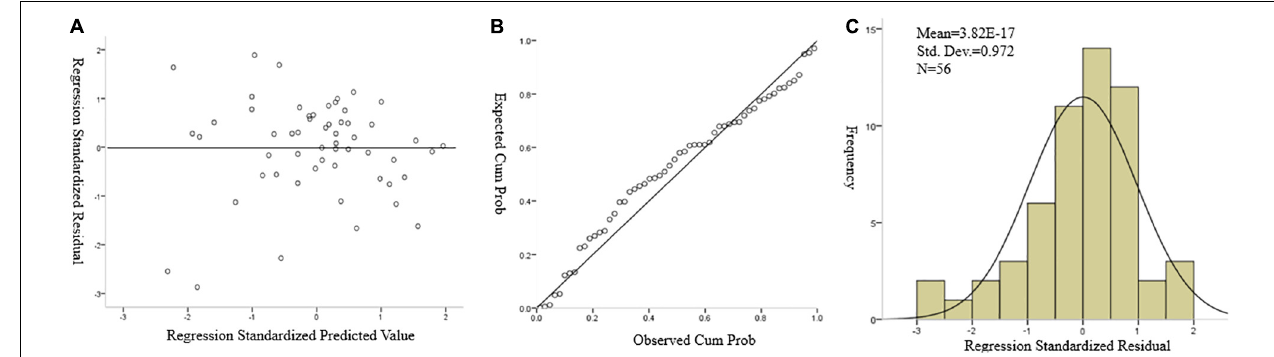
FIGURE 9 | (A) Scatter plot of regression standardized residual against the regression standardized predicted value of dependent variable (academic score). (B) Normal P–P plot of regression standardized residual, the plot of the residual fits the expected pattern well enough to support that the residual is normally distributed. (C) Normal distribution plot of regression standardized residual with zero mean